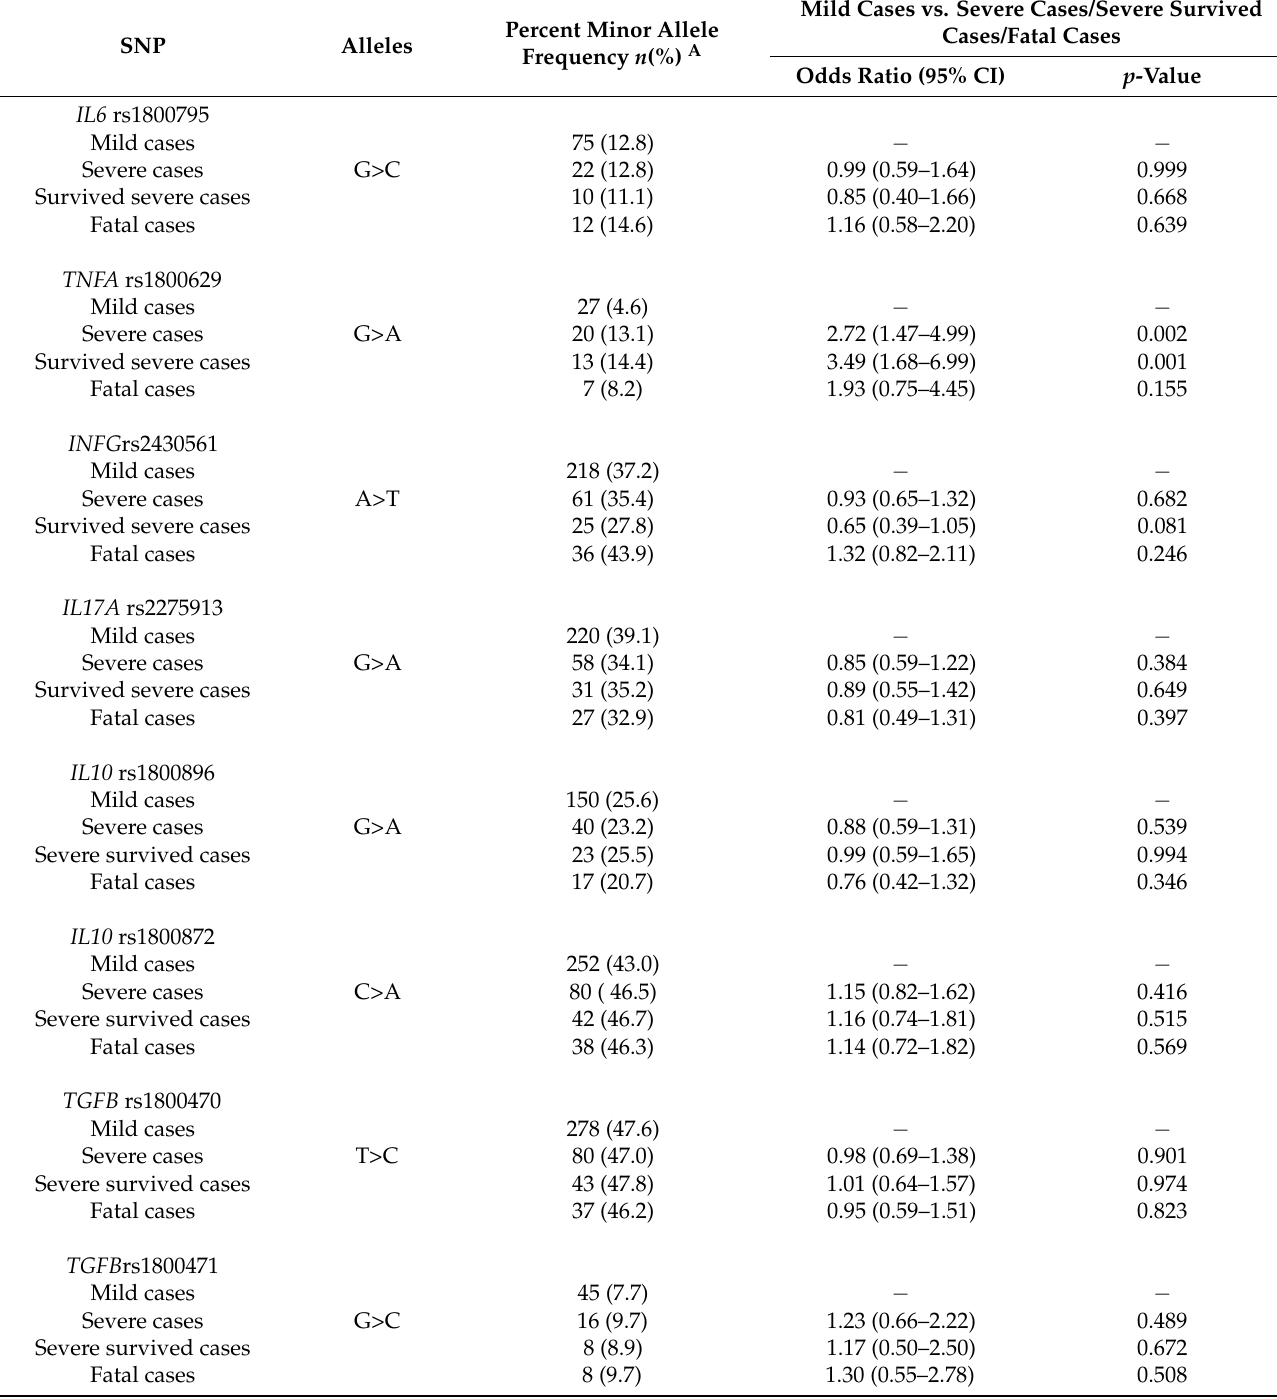
Table 2. Percent allele frequencies of cytokine gene polymorphisms in different Influenza A(H1N1)pdm09 patient groups. Mild Cases vs. Severe Cases/Severe Survived Percent Minor Allele SNP Alleles Frequency n (%) A Odds Ratio (95%